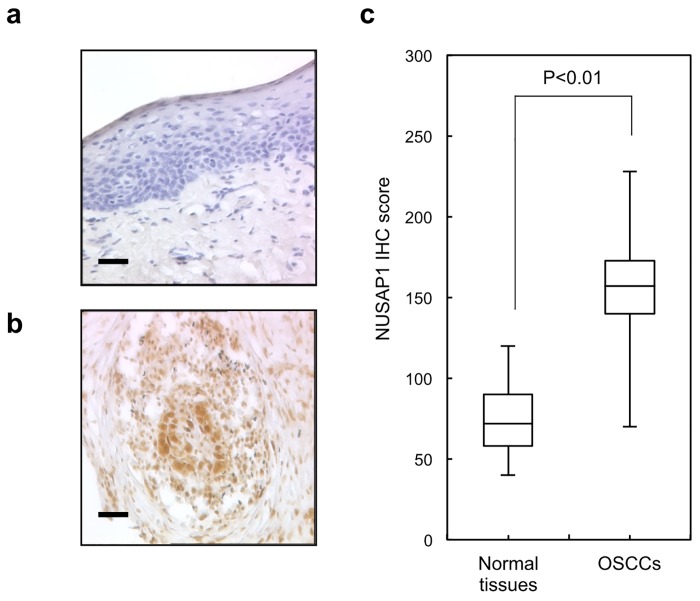
Evaluation of NUSAP1 protein expression in primary OSCCs.Representative IHC results for NUSAP1 in a normal oral tissue and b primary OSCC (original magnification, x400. Scale bars, 50 μm). Strong NUSAP1 immunoreactivity is detected in primary OSCCs, whereas normal oral tissues show almost negative immunostaining. c The state of NUSAP1 protein expression in the normal counterparts and primary OSCCs (n = 70). The NUSAP1 IHC scores for normal oral tissues and OSCCs range from 0 to 38.1 (median 12.8) and 40.2 to 170.3 (median 136.3), respectively. NUSAP1 protein expression levels in OSCCs are significantly (p < 0.001, Mann-Whitney’s U test) higher than that in normal oral tissues.